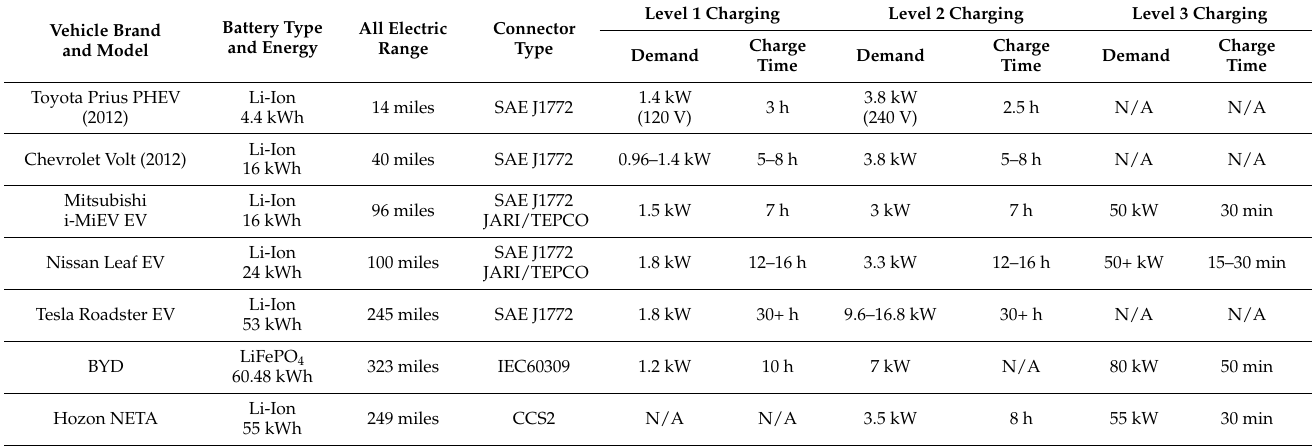
Table 1. Charging characteristics and required infrastructure of some manufactured PHEVs and EVs (data collected from